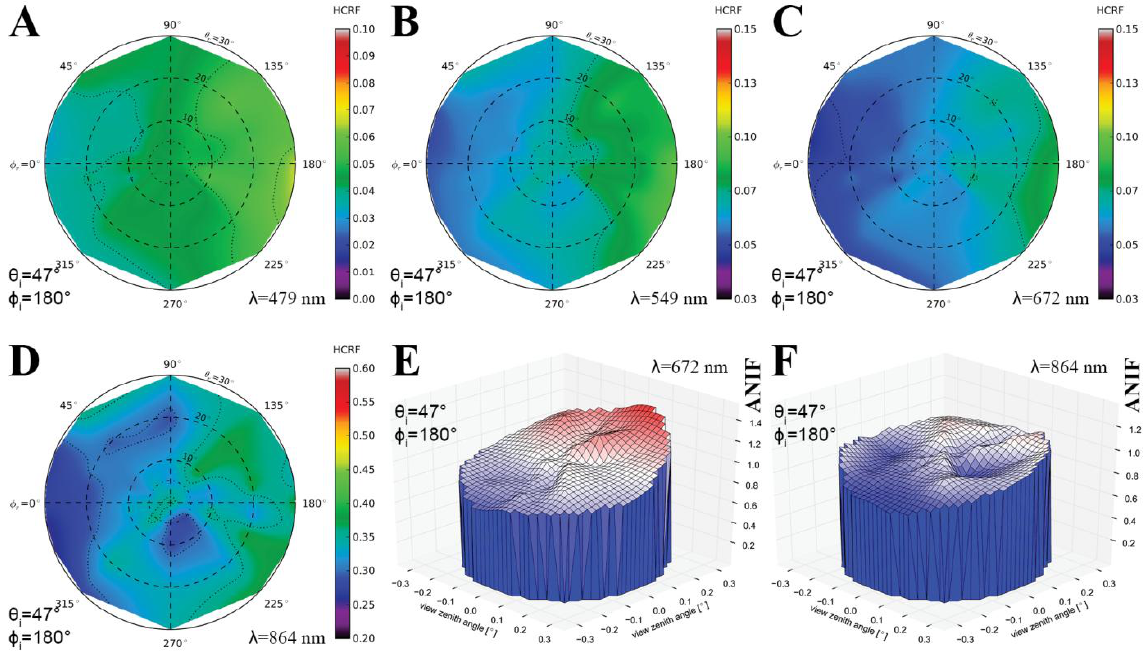
Figure 11. ( A – D ) Polar plots of the HCRF data for all view angles at wavelengths of (A) 479 nm; (B) 549 nm; (C) 672 nm; and (D) 864 nm. ( E – F ) 3D visualization of